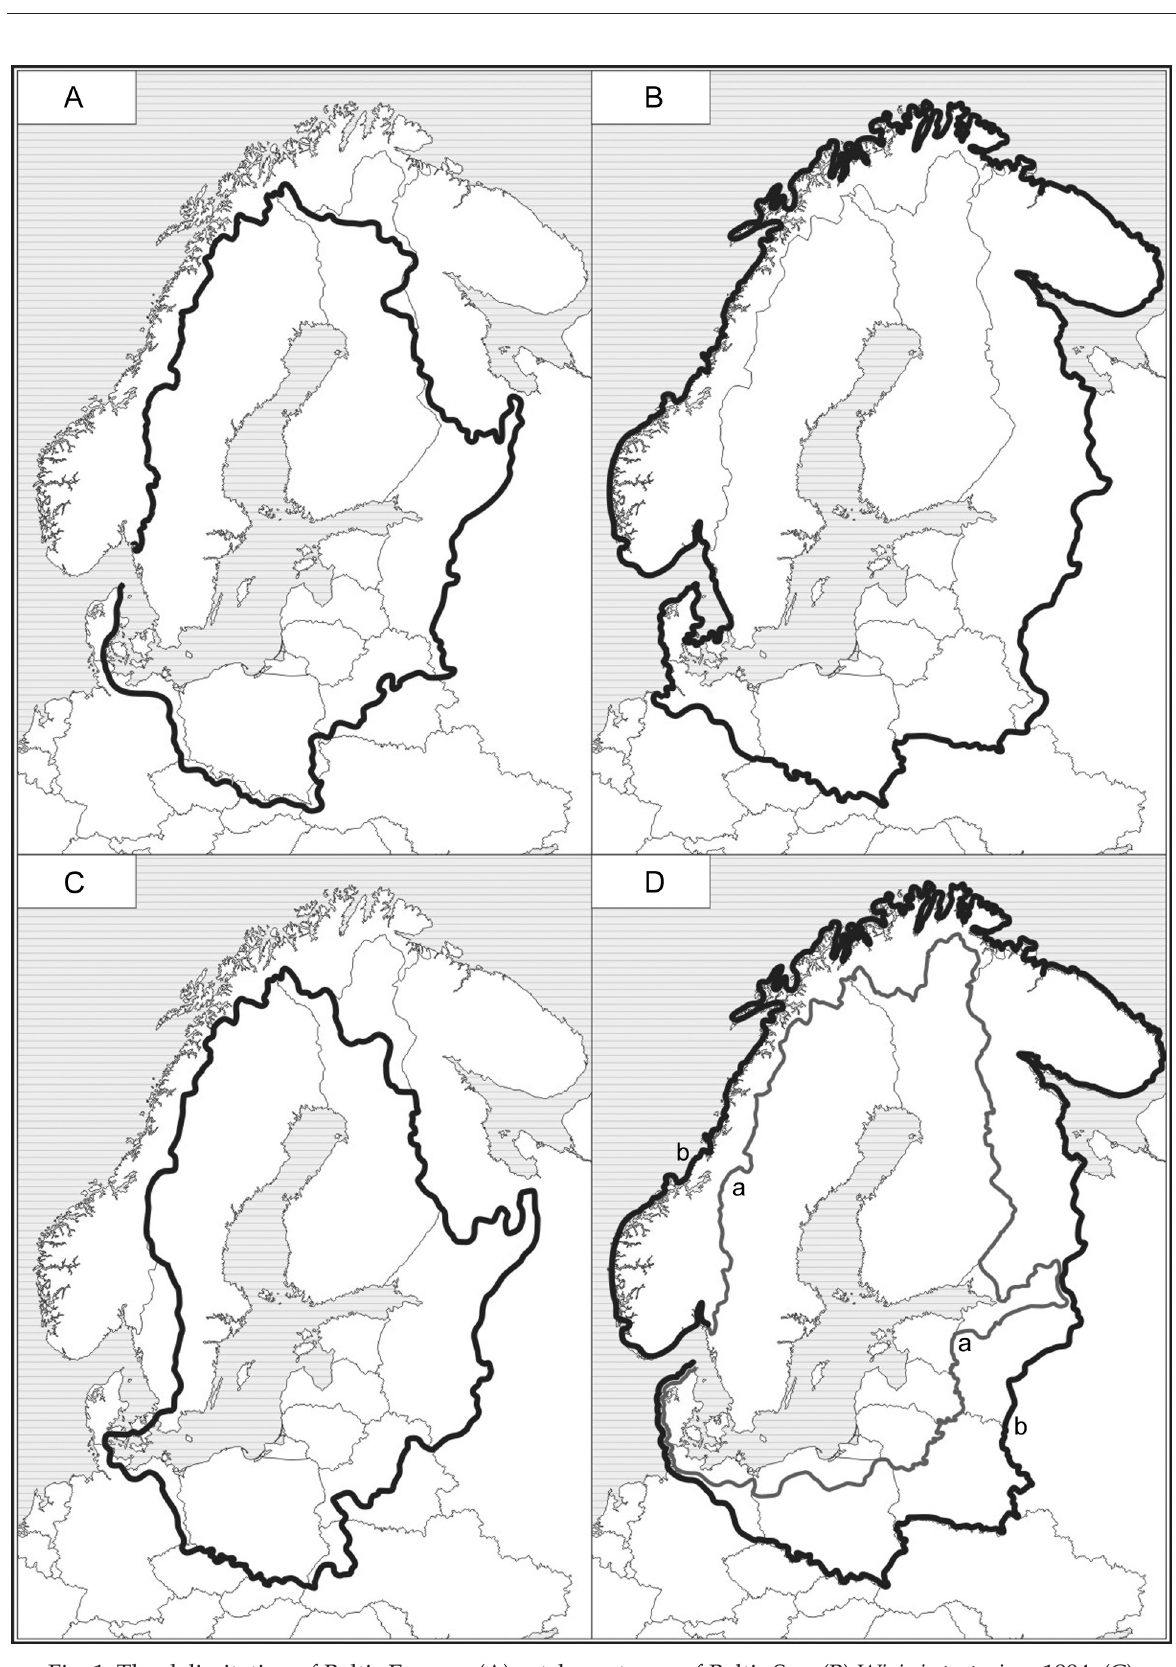
Fig. 1. The delimitation of Baltic Europe: (A) catchment area of Baltic Sea, (B) Wizje i strategie… 1994, (C) Buchhofer 1997, (D) Palmowski 2000 – (a) core area, (b) extended area. Source: authors own study based on the above mentioned